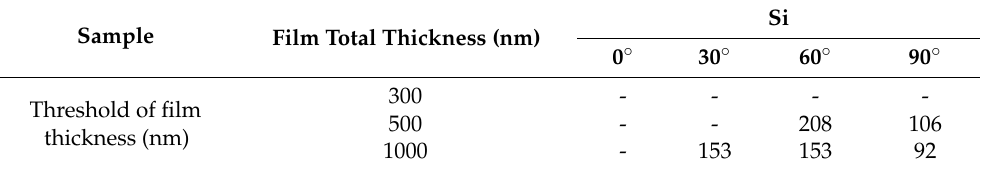
Table 2. Film thickness threshold of samples affected by the shadow effect on the Si substrate.